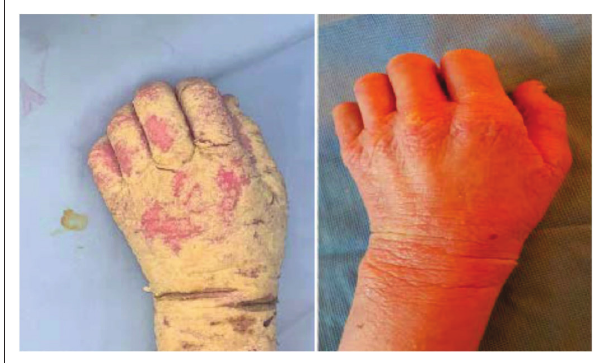
FIGURE 9: Crusted scabies before and after treatment. This patient was treated with permethrin 5 % lotion, two applications a week